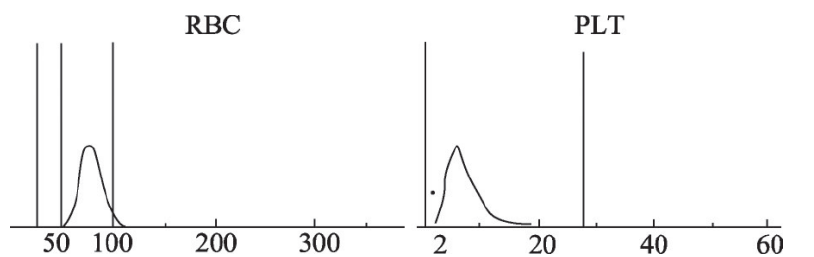
Figure 5. One-dimensional scalar field visualization [7]. The horizontal axis represents time and the vertical axis represents the number of RBC or PLT.